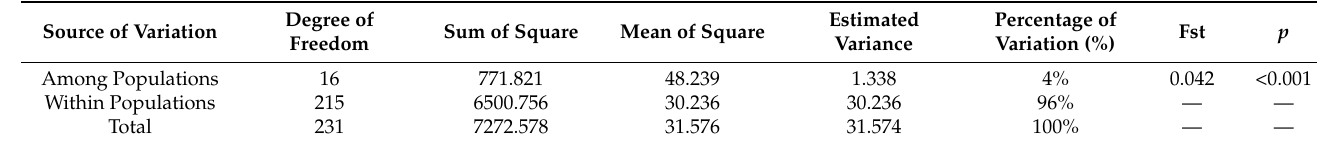
Table 4. AMOVA of the original population.